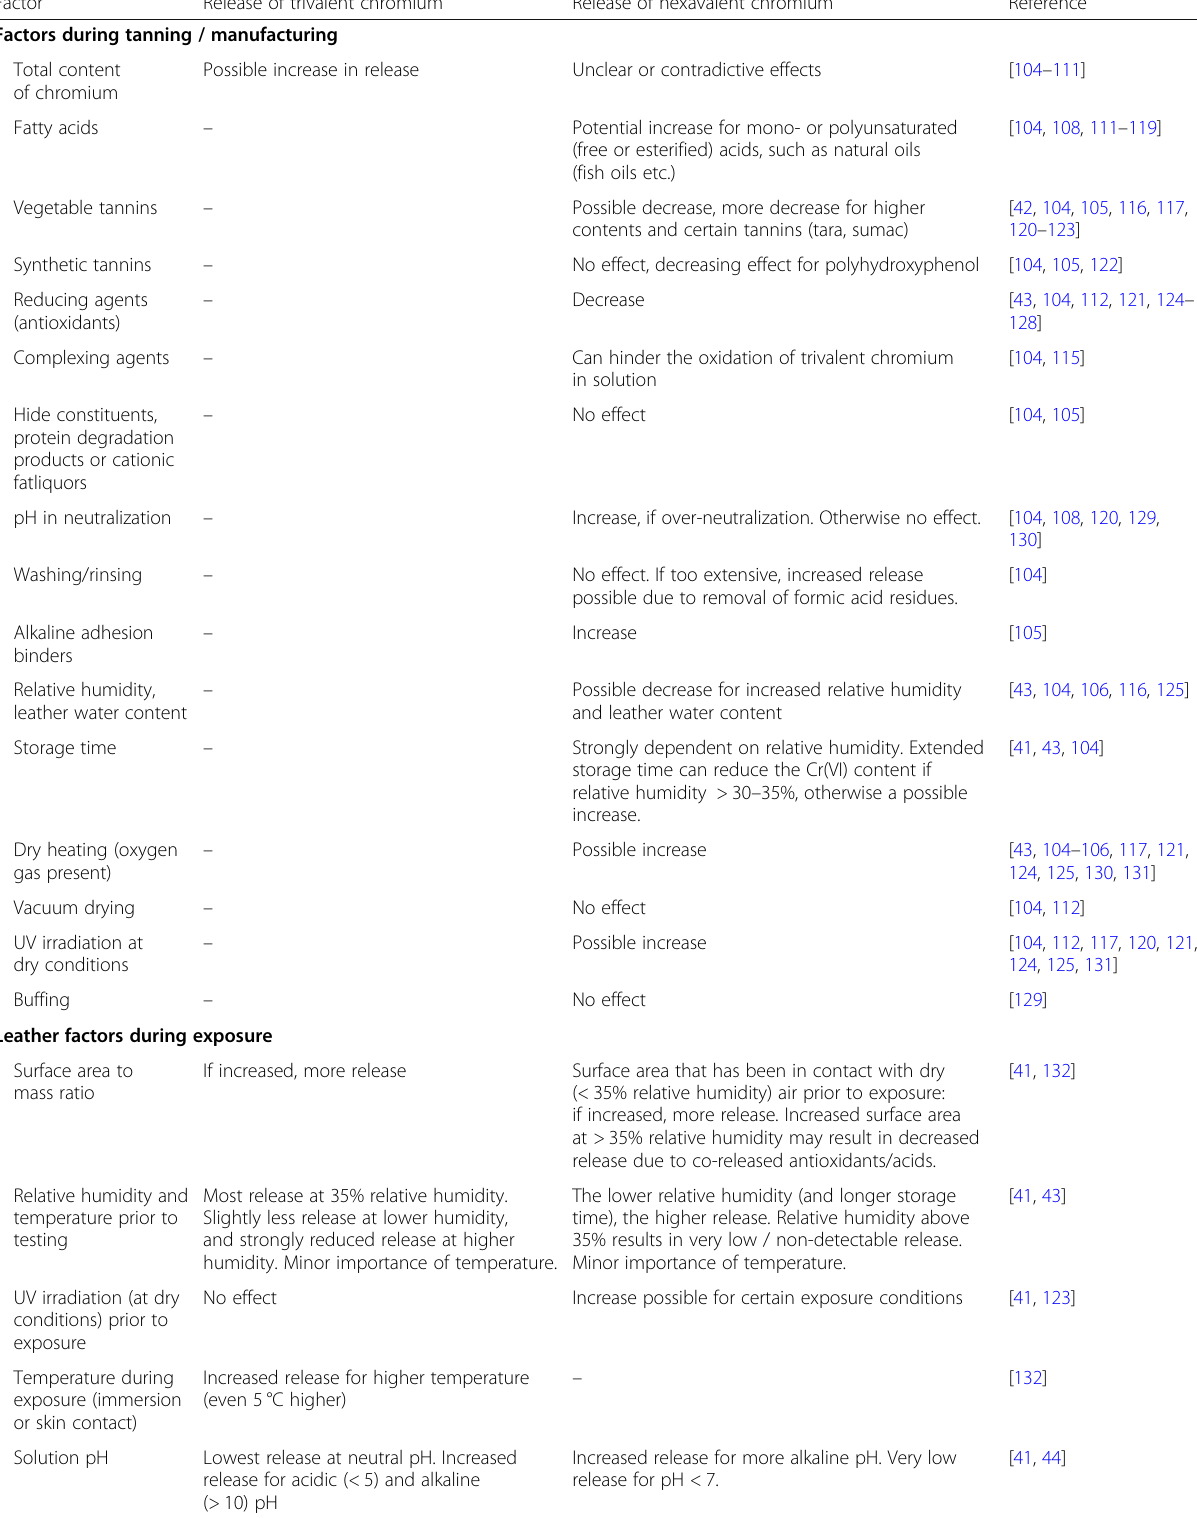
Table 2 Most important tanning, leather, and exposure factors/conditions for the release of trivalent and hexavalent chromium from chromium-tanned